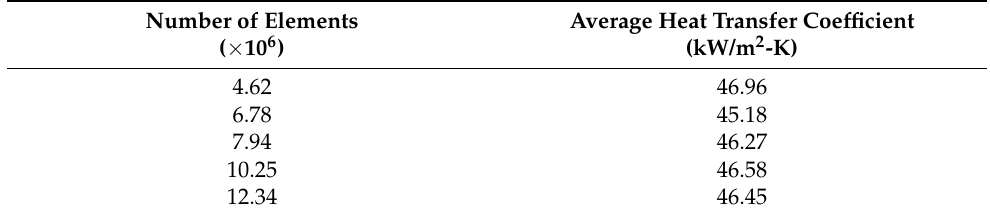
Table 3. Grid independence